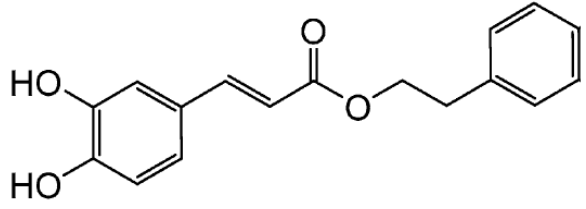
Figure 1. Chemical structure of caffeic acid phenethyl ester.